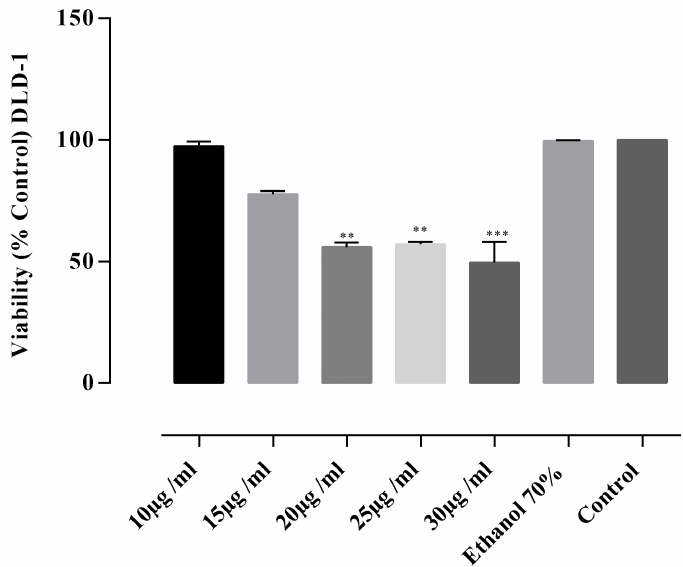
Figure 3. Cytotoxic activity assay results of F. schleicheri (FS3) extract on DLD cell line. The extract was tested at five different concentrations 10–30 µ g/mL. Negative control—untreated cells. Inter- nal control—cells treated with 70% ethanolic solution. Values represent the mean ± SD of three independent evaluations; ** p < 0.001; *** p <